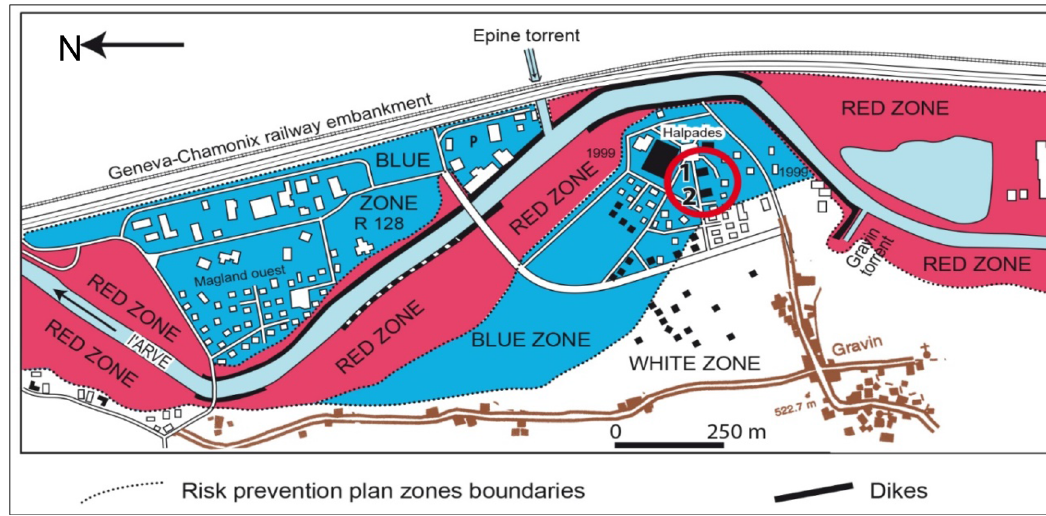
Fig. 1 Location of the two buildings (Fig. 2), encircled in red, on the 1997 Magland risk prevention